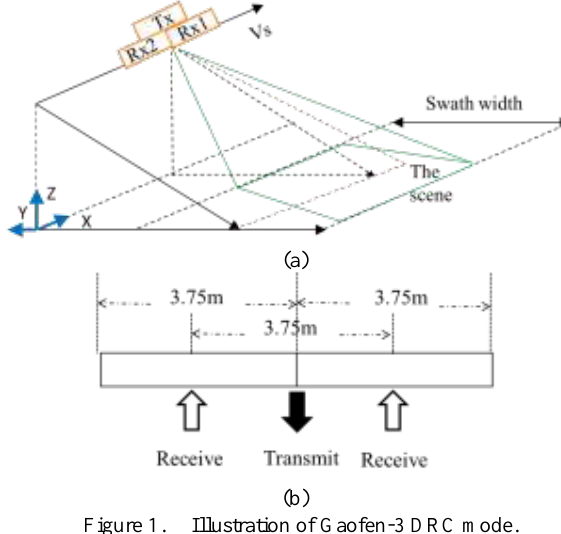
Figure 1. Illustration of Gaofen-3 DRC mode.